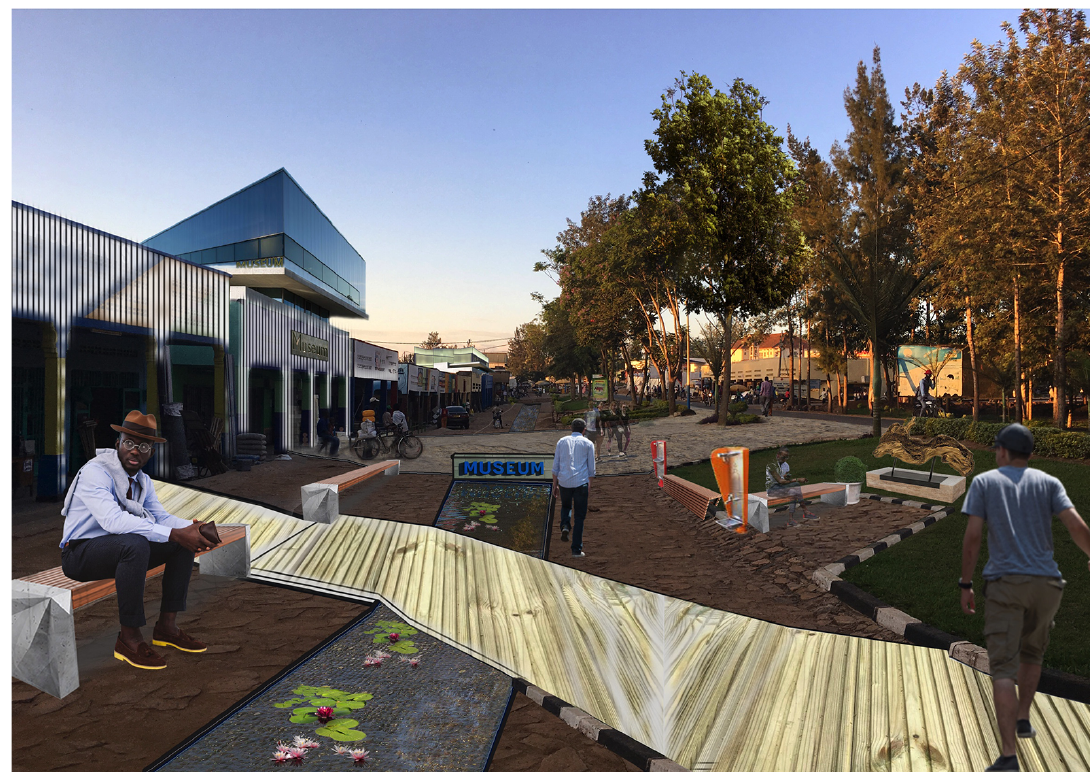
Figure 2. Photoshopped street in Nyagatare where public space elements were added, shared via social media to initiate discussion, in July